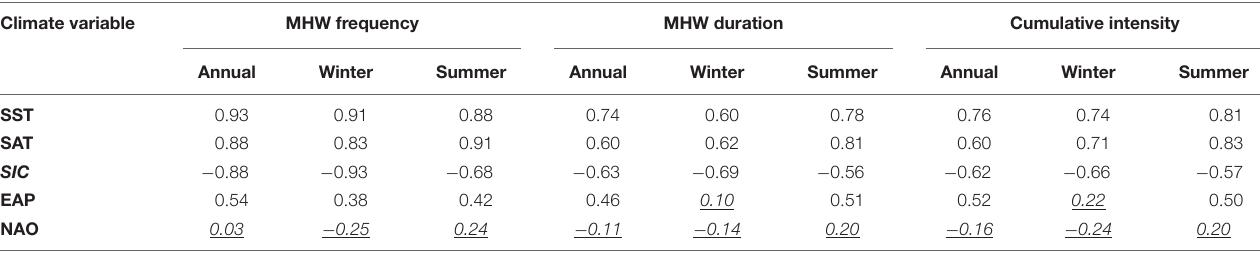
TABLE 1 | Correlation coefficients (R) between MHW characteristics (frequency, duration, and cumulative intensity) and climate modes (EAP and NAO) and variables (SST, SAT, and SIC ). Climate variable